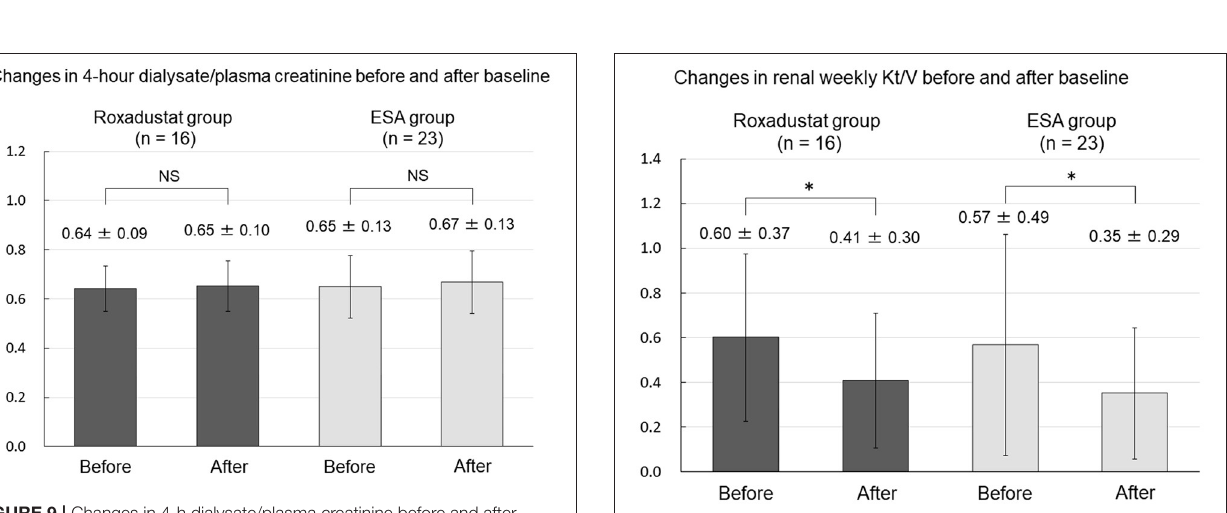
FIGURE 10 | Changes in renal weekly Kt/V before and after baseline in the Roxadustat and ESA groups. ESA, erythropoiesis-stimulating agent; Kt/V, urea clearance; * p <